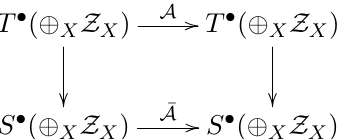
Figure 1 . Here the bordism on the left, which is a bordism from ∅ to ∅ and has no boundary, is weighted with 1 . On the other hand, the surface on the right, which has nonempty boundary 2! S 1 q S 1 , and can be interpreted as a bordism in many ways, depending on whether the circles are ingoing or outgoing, is weighted with 1